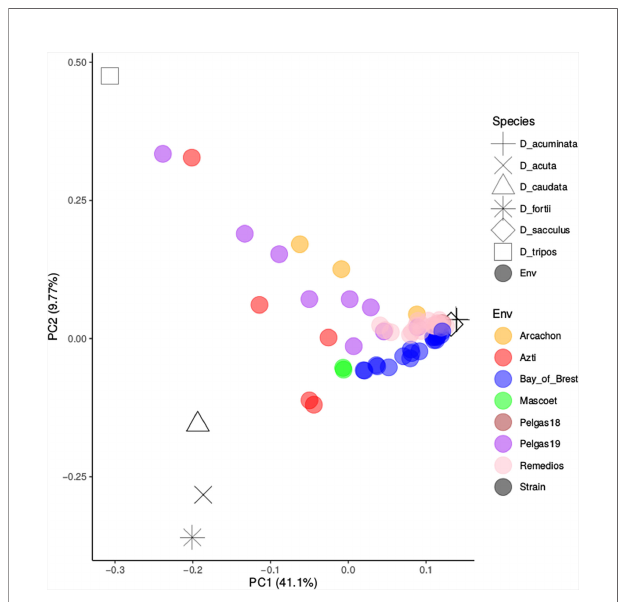
FIGURE 7 | PCA analysis of species composition in Dinophysis spp. populations. The in-situ samples are represented by colored dots and the strains by black